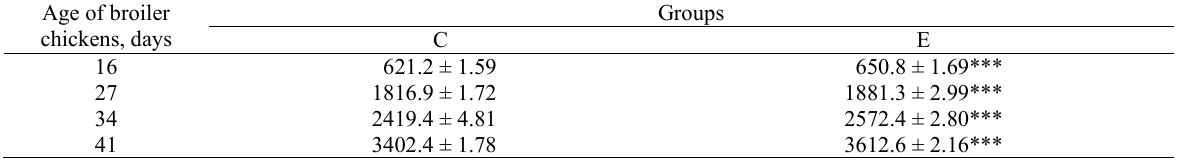
Growth intensity of broiler chickens, g (М ± m; n = 30) Age of broiler chickens, days